Question: Generate an informative caption for the figure above.
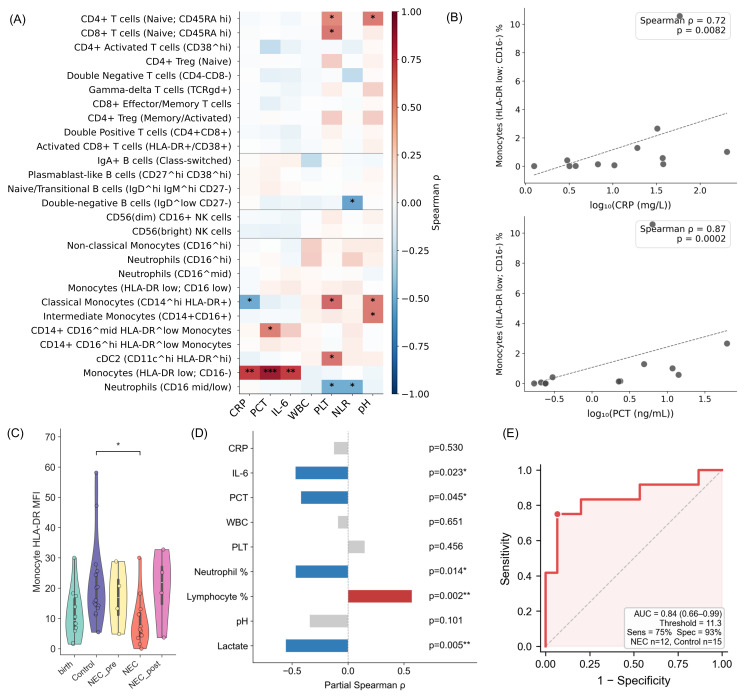
Answer: Monocyte HLA-DR suppression tracks NEC inflammatory severity and provides an exploratory within-cohort readout. (A) Heatmap of Spearman correlations between immune cell subtypes and clinical laboratory variables at NEC onset, including inflammatory, hematologic, acid-base, and metabolic indicators. Cell colors represent Spearman rho, and asterisks indicate statistically significant associations after multiple-testing correction. (B) Scatter plots showing associations between HLA-DR-low CD16-negative monocyte frequency and C-reactive protein or procalcitonin. Dashed lines indicate fitted trends; Spearman correlations and P values are shown. (C) Monocyte HLA-DR median fluorescence intensity across sample groups. (D) Partial Spearman correlations between monocyte HLA-DR expression and clinical variables after adjustment for relevant covariates, with P values shown at right. (E) Exploratory receiver-operating-characteristic analysis of monocyte HLA-DR expression comparing NEC-at-onset and postnatal Control samples. The plot reports AUC = 0.84 with bootstrap 95% confidence interval 0.65-0.99. Asterisks denote statistical significance as displayed. AUC, area under the receiver-operating-characteristic curve; CD, cluster of differentiation; CRP, C-reactive protein; HLA-DR, human leukocyte antigen-DR; IL, interleukin; MFI, median fluorescence intensity; NEC, necrotizing enterocolitis; NLR, neutrophil-to-lymphocyte ratio; PCT, procalcitonin; PLT, platelet count; ROC, receiver-operating characteristic; WBC, white blood cell count.